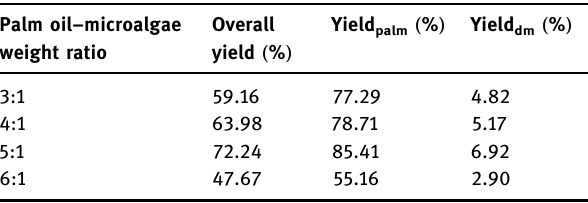
Table 4: Biodiesel yield for various methanol – palm oil molar ratios Methanol – palm oil